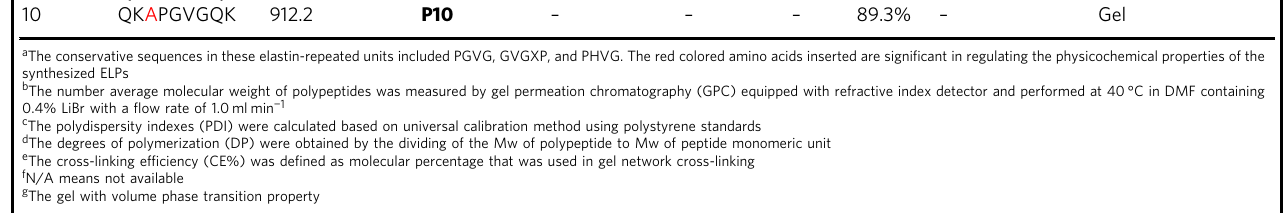
f N/A means not available g The gel with volume phase transition